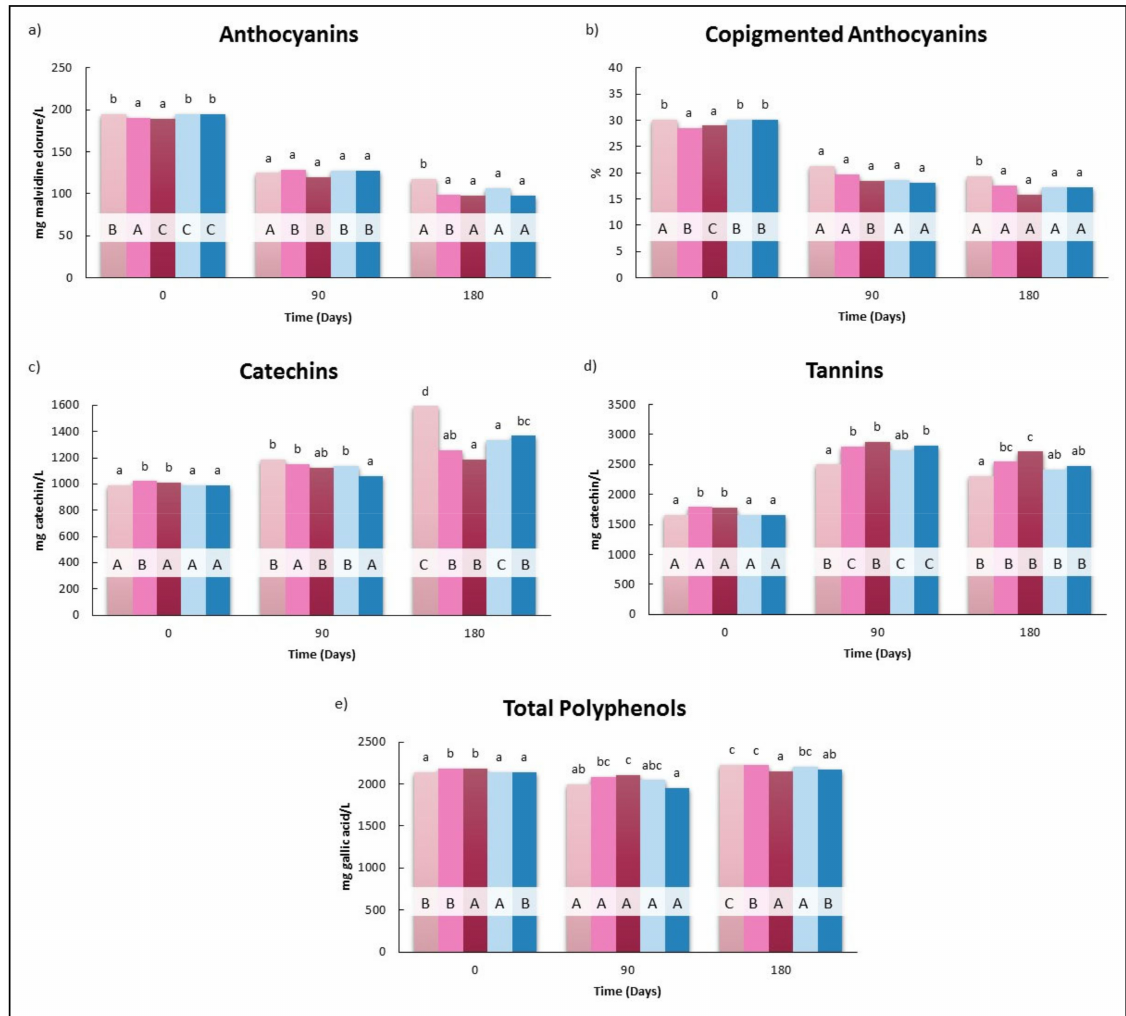
Figure 4. Effect of the application of HHP and maceration with holm oak chips on the evolution of polyphenolic composition in Tempranillo wine: ( a ) Anthocyanins, malvidine- 3-glycoside chloride, mg/L; ( b ) Copygmented anthocyanins (%); ( c ) catechin, mg catechin/L; ( d ) Tannins, mg catechin/L; ( e ) Total polyphenols content, mg gallic acid/L). B: Wines bottled without any treatment; HHP5, HHP30: Wines bottled after maceration of holm oak chips (5 g/L) with HHP treatments (400 MPa, 5 and 30 min). M and T: Wines bottled after storage for 45 days in tanks with and without maceration of holm oak chips (5 g/L). Different lower case letters indicate a significant difference ( p < 0.05) among the treatments for the same day. Different capital letters indicate a significant difference ( p < 0.05), for the same treatment on different